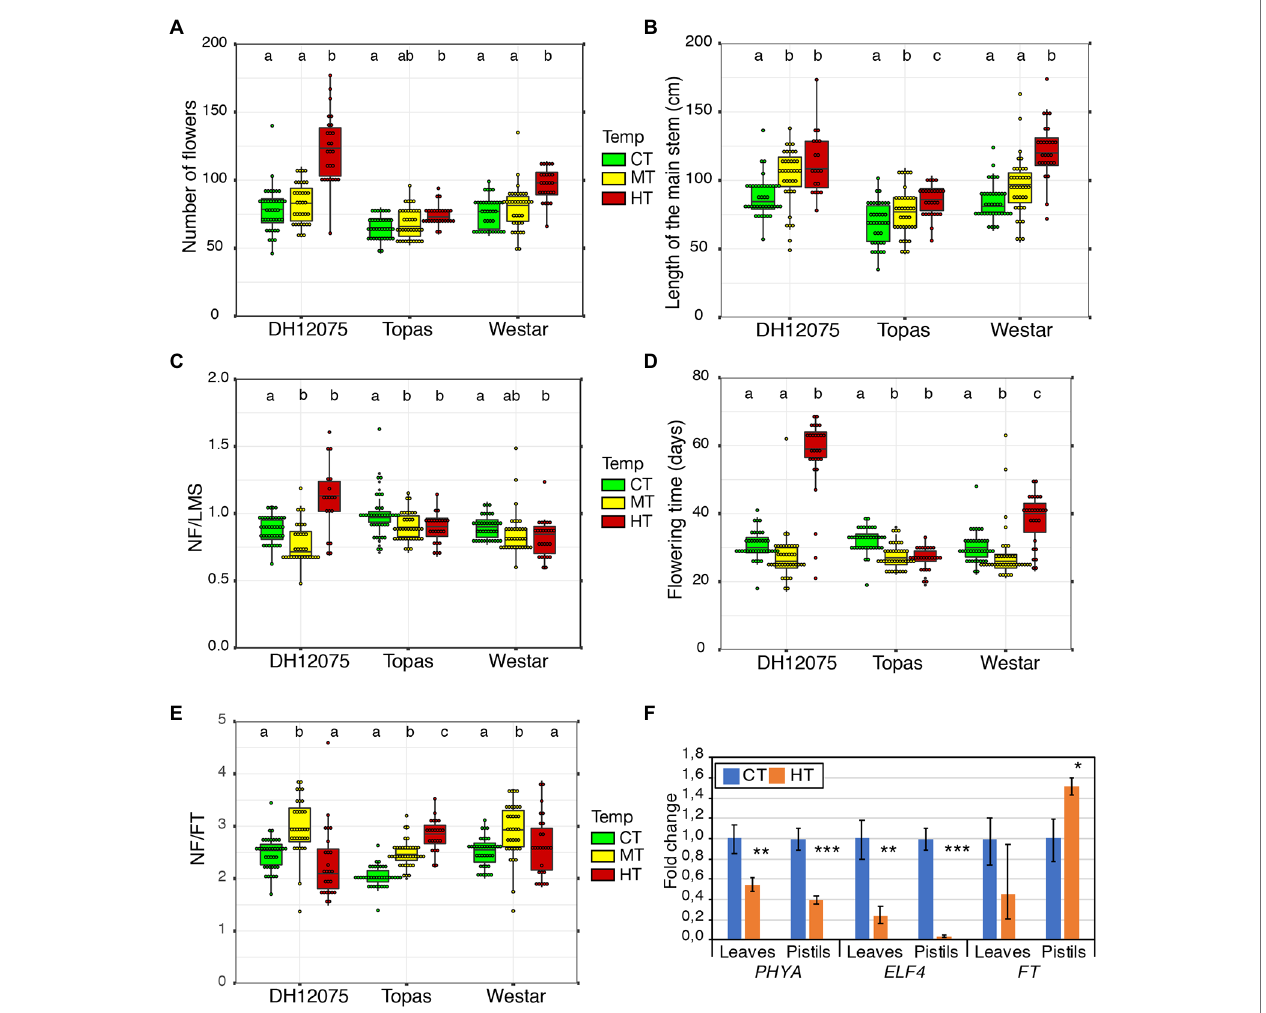
FIGURE 1 | Effects of high temperatures on flowering traits and seed production. (A–E) The number of flowers (NF; A ), the length of the main stem (LMS; B ), the number of flowers per cm of inflorescence (NF/LMS; C ), the flowering time (FT; D ), and the number of flowers per day (NF/FT; E ) were quantified in DH12075, Topas, and Westar cultivars at CT (green), MT (yellow) and HT (red). The data are presented as boxplots. The box represents the interquartile range, and the line inside the box represents the median. Each dot represents a measurement. The Pearson correlation coefficient between LSM, FT, and NF, is shown in Supplementary Table S2 . Boxes with the same letters (a, b, and c) within each cultivar do not differ significantly ( p < 0.05). (F) Expression analysis by RT-qPCR of BnaPHYA , BnaELF4 , and BnaFT in Westar leaves and pistils. The graph displays the fold changes in expression between CT (blue) and HT (orange). Asterisks indicate statistically significant difference in HT in a paired Student’s t -test ( t -test; *, **, and *** correspond to value of p 0.05 > p > 0.01, 0.01 > p > 0.001, and p < 0.001, respectively). Primers and LOC information are presented in Supplementary Table S1